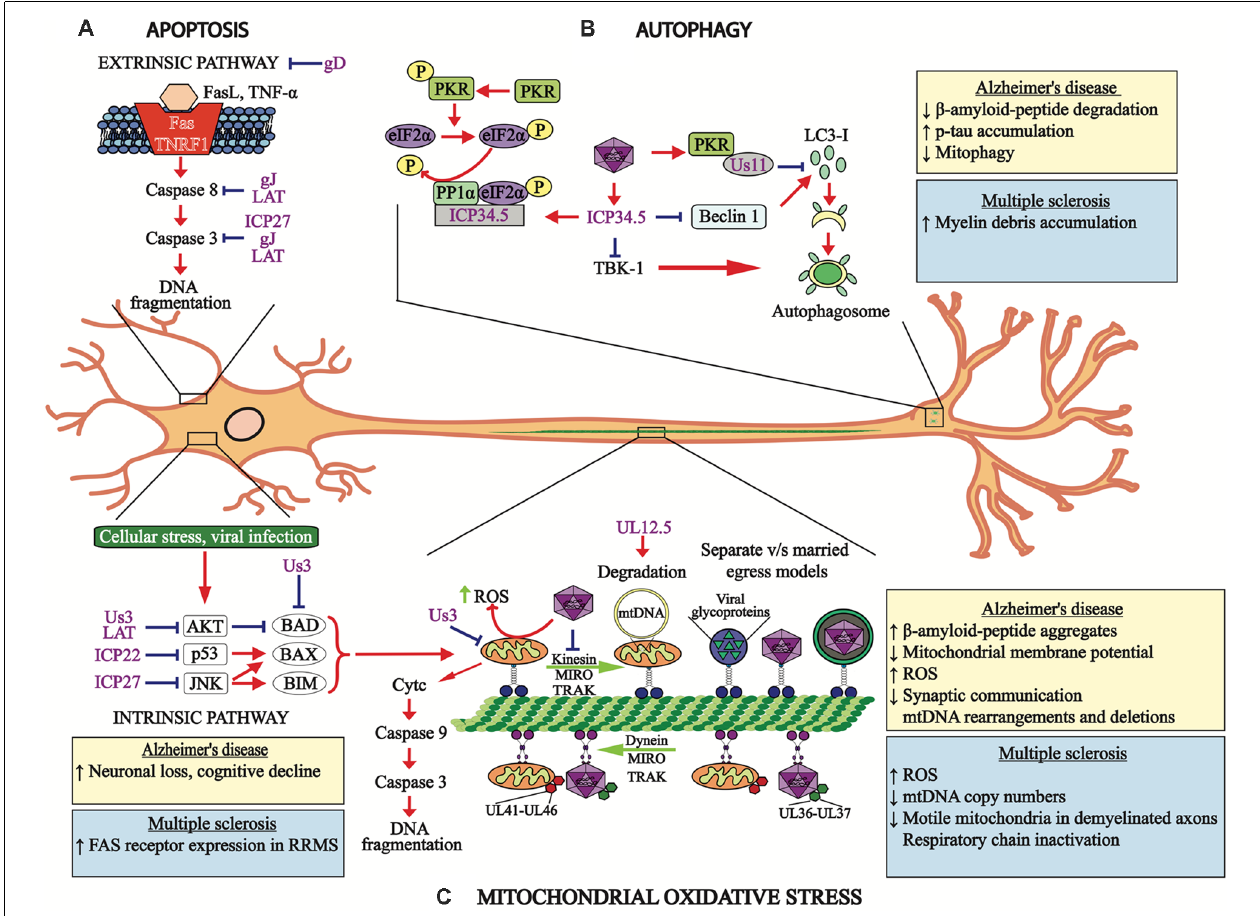
FIGURE 2 | HSV-1 modulates cellular processes. (A) HSV-1 modulates apoptosis-related pathways. The apoptosis extrinsic (upper section) and intrinsic (lower section) pathways are modulated by HSV-1 proteins, such as the immediate early proteins infection cell protein 22 (ICP22), ICP27 and US3, late viral proteins glycoprotein D (gD) and gJ, as well as the latency-associated transcript (LAT) transcript, which hamper events leading to apoptosis at different stages of signaling cascades and at distinct time-points after infection. (B) HSV-1 modulates autophagy. Viral protein US11 interaction with PKR inhibits LC3-I conversion into LC3-II. HSV-1 ICP34.5 inhibits autophagosome formation by blocking beclin-1 and subsequent LC3-I conversion into LC3-II, which is necessary for proper autophagosome function. The viral protein ICP34.5 also inhibits TBK-1, which blocks autophagosome formation. (C) Mitochondria oxidative stress is also modulated by HSV-1 infection. Both, mitochondria and HSV-1 transport are mediated by retrograde and anterograde processes involving microtubules. Importantly, HSV-1 infection blocks the transport of mitochondria and viral tegument proteins (UL41 and UL46) migrate with this organelle within infected neurons. Retrograde transport of the HSV-1 capsid is accompanied by the viral tegument proteins UL36 and UL37. Anterograde transport of HSV-1 components to neuron termini can be mediated either separately or in a conjoint manner, which are known as the “married” and the “separate” models. The viral protein UL12.5 produces mitochondria DNA degradation and the viral protein US3 protein blocks the electron transport chain within this organelle. The boxes show the cellular processes or pathologies that occur in Alzheimer’s disease (AD) (yellow boxes) or multiple sclerosis (MS; blue boxes) associated with apoptosis, autophagy and mitochondria oxidative stress. RRMS, relapsing-remitting